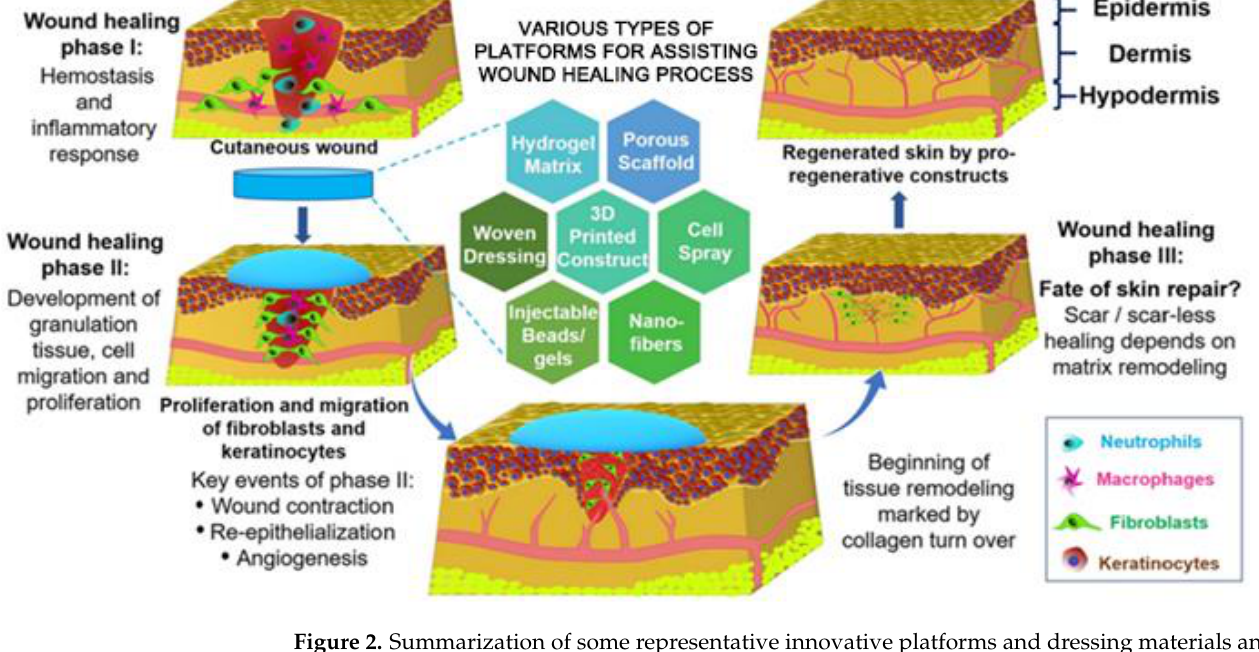
Figure 2. Summarization of some representative innovative platforms and dressing materials and Schematic of the representative concept and mechanisms of a wound healing process using an advanced dressing material. Reprinted with permission from ref. [45], Elsevier, 2019.